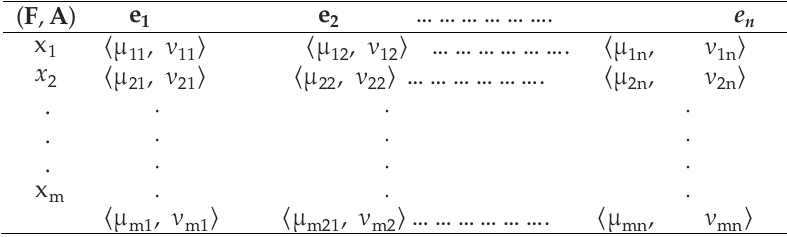
Table 1. Representation of